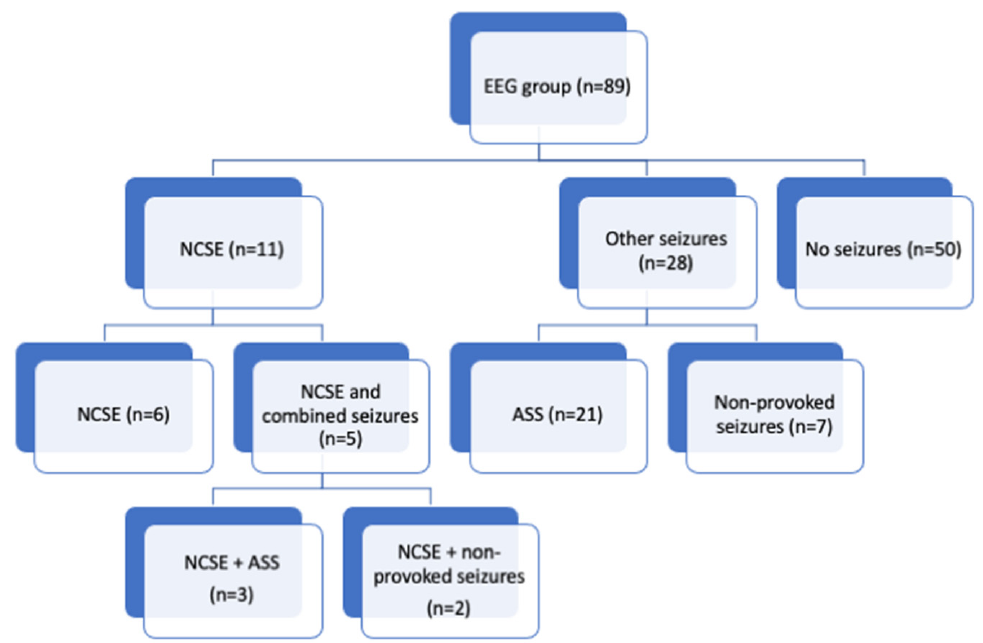
Figure 1. Frequency of seizures in patients undergoing EEG studies. NCSE, patients with clear ictal activity in their EEG in accordance with the Salzburg criteria (see [12]); Other seizures, distinct clinically observed seizures in the ICU with or without ictal EEG activity at the time of the EEG study; No seizures, altered consciousness ± abnormal movements but no evident clinically observed seizures or corresponding ictal EEG changes.